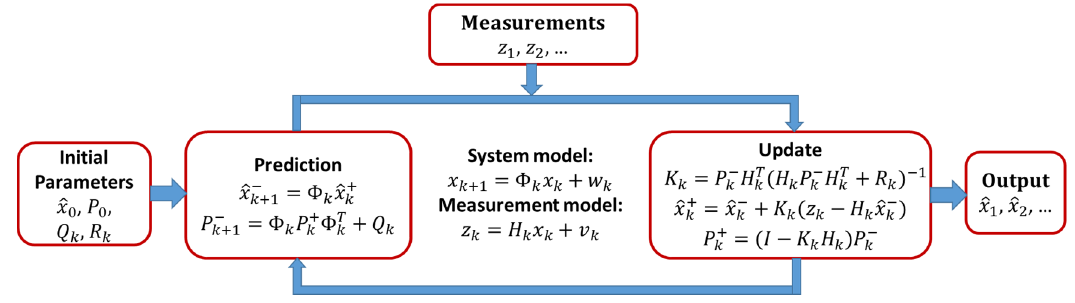
Figure 2. Kalman filter loop.